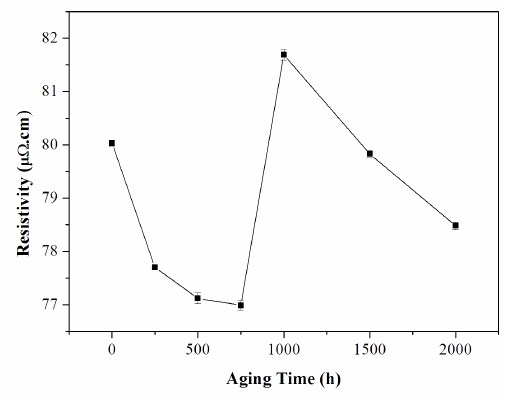
Figure 10. DC resistivity of studied